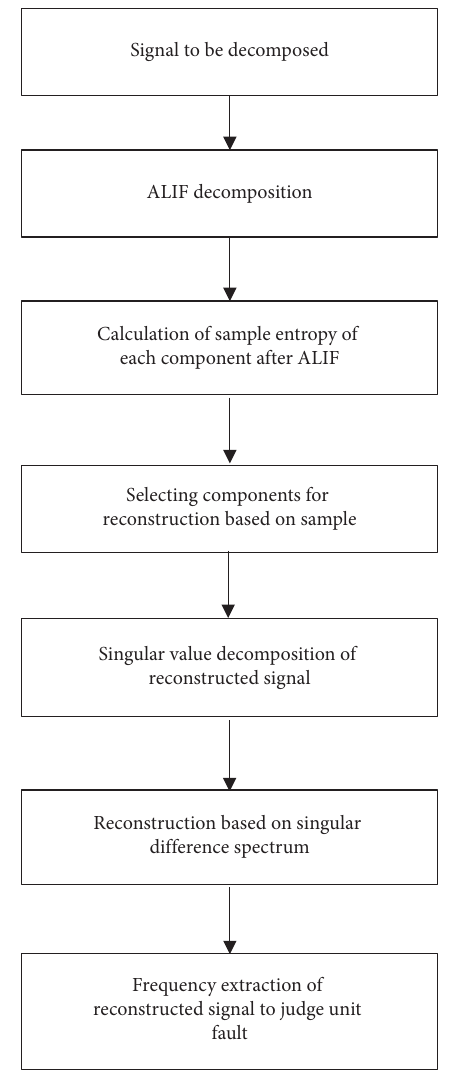
Figure 1: Denoising